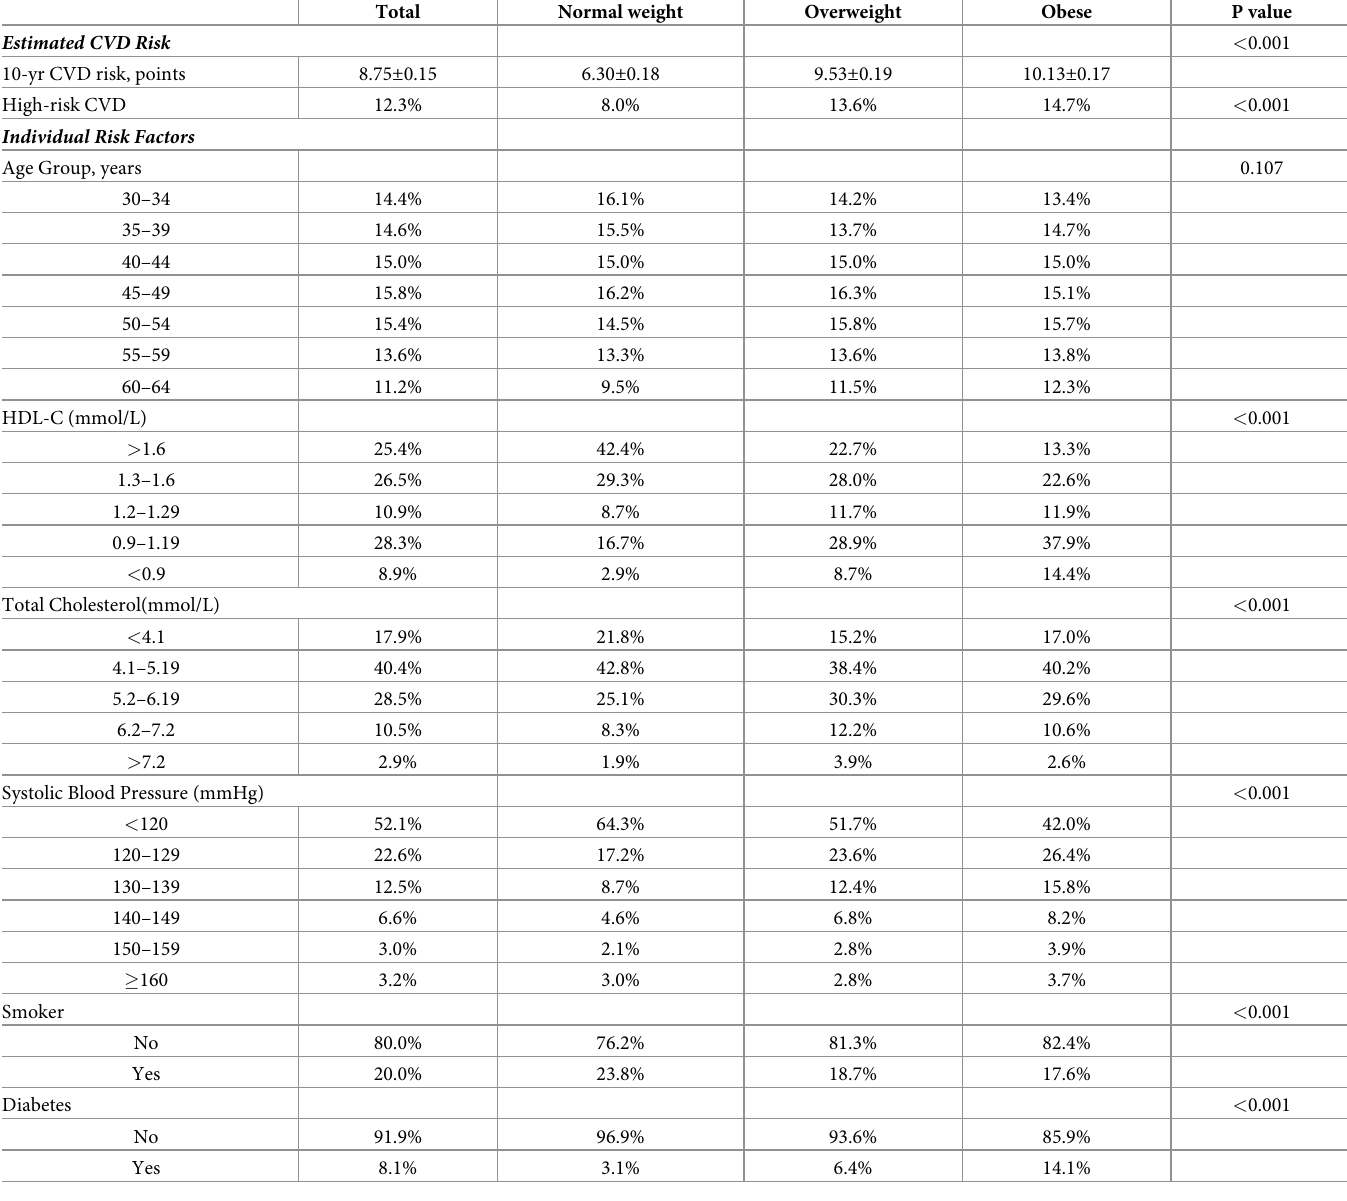
Table 2. Estimated cardiovascular Risk and individual risk factors among U.S adults age 30–65 years old with no history of cardiovascular disease (population- weighted, NHANES 2007–2016). Normal